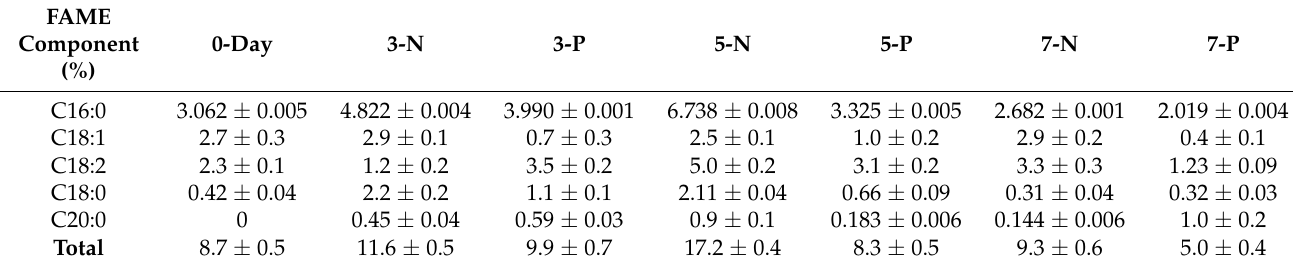
Table 6. FAME composition of Chlorella sorokiniana 1 (isolated from BG-11 at pH-9) cultured in nutrient amended media. (3, 5, and 7 denote the culture time in days, and N and P represent the N-amended medium and P-amended media, respectively). FAME